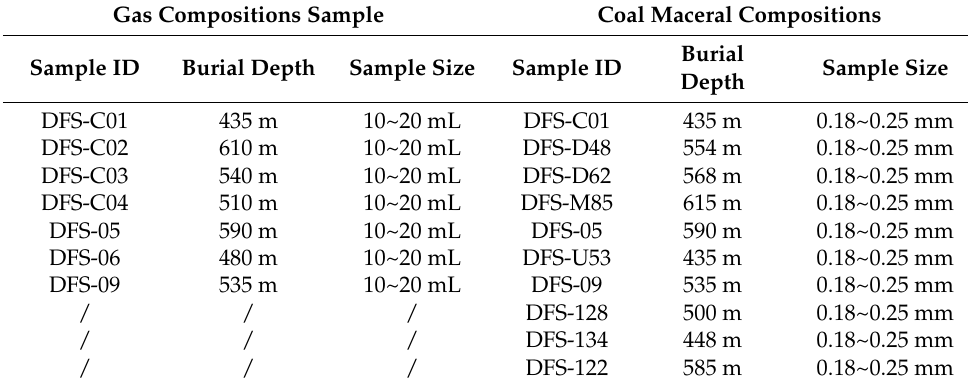
Table 1. Basic information of test